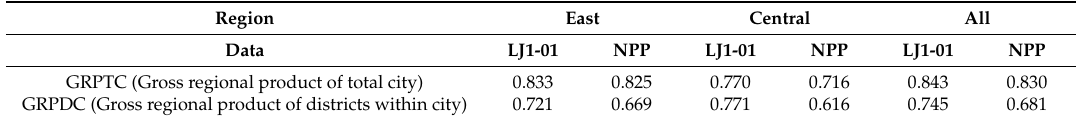
Table 3. Linear regression R 2 values for the GRP and